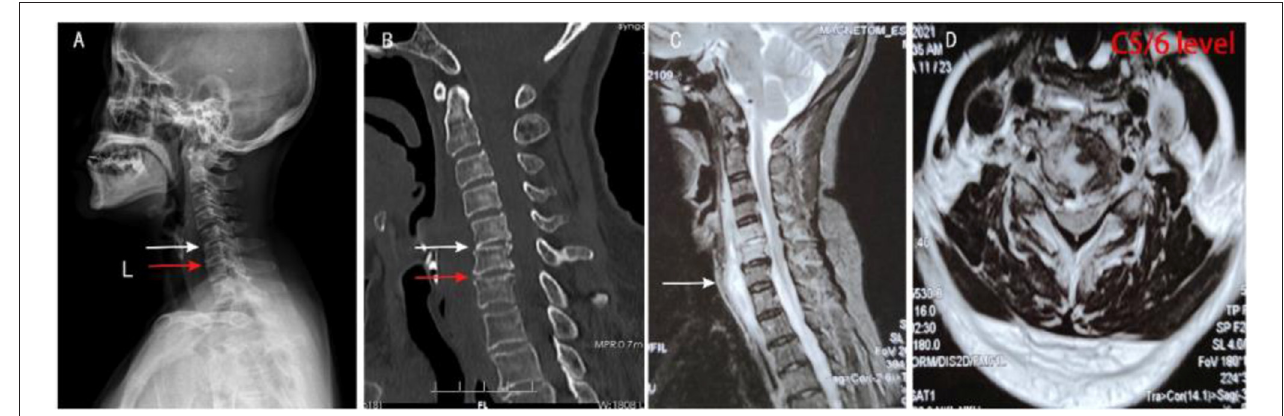
FIGURE 1 | Preoperative imaging results of the patient. (A,B) Preoperative cervical spine X-ray and CT showed narrowing of the C5/6 (white arrow) and C6/7 (red arrow) intervertebral space, poor bone structure at the upper and posterior edges of the C6 vertebral body, and thickened soft tissue at the anterior edge of the C4-T2 vertebral body. (C,D) Preoperative sagittal and transverse MRI of the cervical spine showed the abscess was located in front of the C2-T2 vertebral body (white arrow) and also in the C5/6 intervertebral space, both C5 and C6 vertebral bodies showed hypersignal changes.